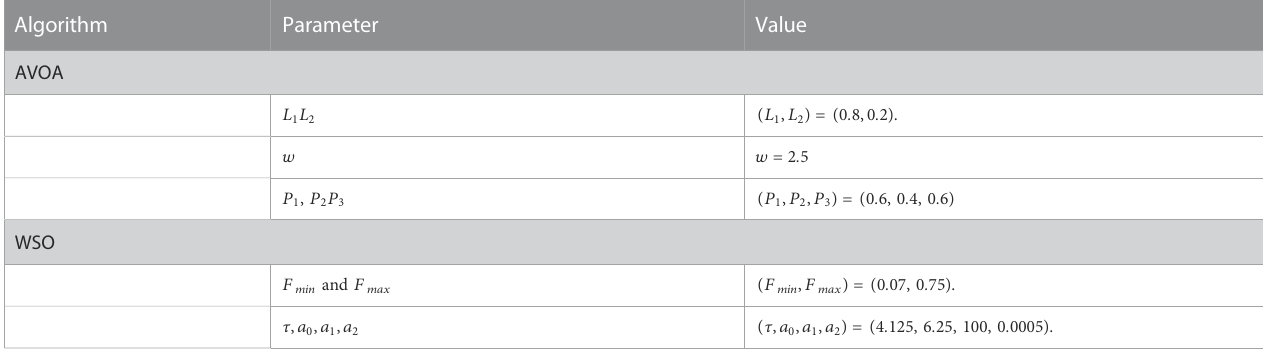
TABLE 1 ( Continued ) Parameter values for the competitor algorithms.